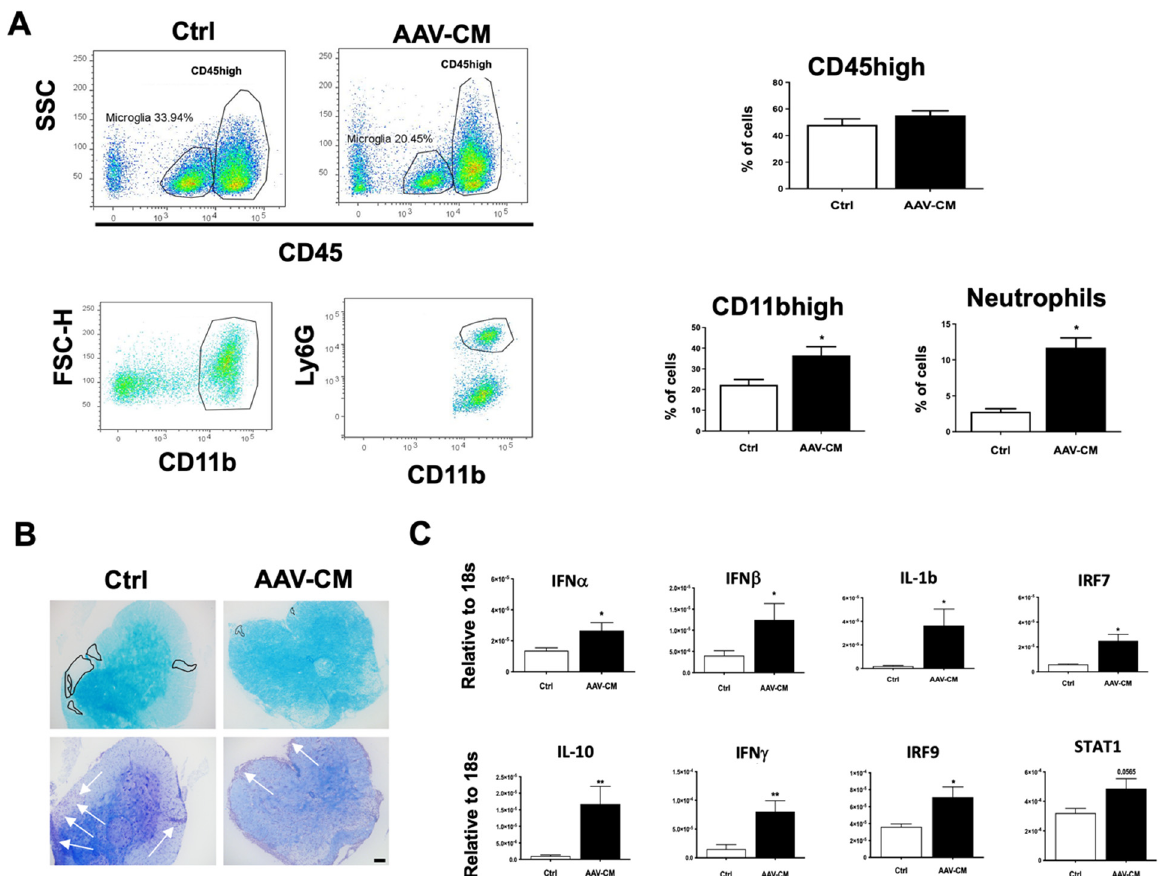
Figure 4. Intrathecal AAV-CM in mice with EAE induced the recruitment of myeloid cells, including neutrophils, to the CNS and reduced demyelination. ( A ) Flow cytometry profiles of brains of mice with EAE-treated with intrathecal AAV-CM or a control (ctrl). CD45high leukocyte populations are distinguished from CD45dim microglia. The proportion of CD45+ cells in the CNS remained similar in response to intrathecal AAV-CM treatment compared to the control EAE mice. Flow cytometric analysis revealed that the proportion of CD11bhigh and neutrophils were significantly increased upon intrathecal AAV-CM. n = 3–6 per group. ( B ) Images of lumbar spinal cord sections of mice with EAE stained with LFB and Cresyl violet. In the control group of mice, Cresyl violet staining showed cell infiltration into the parenchyma of the spinal cord (arrows), which was correlated with extensive loss of LFB (marked area) in corresponding areas. Mice with EAE that were treated with intrathecal AAV-CM showed cell accumulation in the meninges and reduced loss of LFB staining. Scale bar. 100 µm. ( C ) RT-qPCR analysis of brains showed IFN α , IFN β , IFN γ , IL-10, IL-1 β , IRF7 and IRF9 were significantly (STAT1, p < 0.0565) induced upon intrathecal AAV-CM treatment at 1 day post dose ( n = 6–8). Data are presented as mean ± SEM. The results were analyzed using the two-